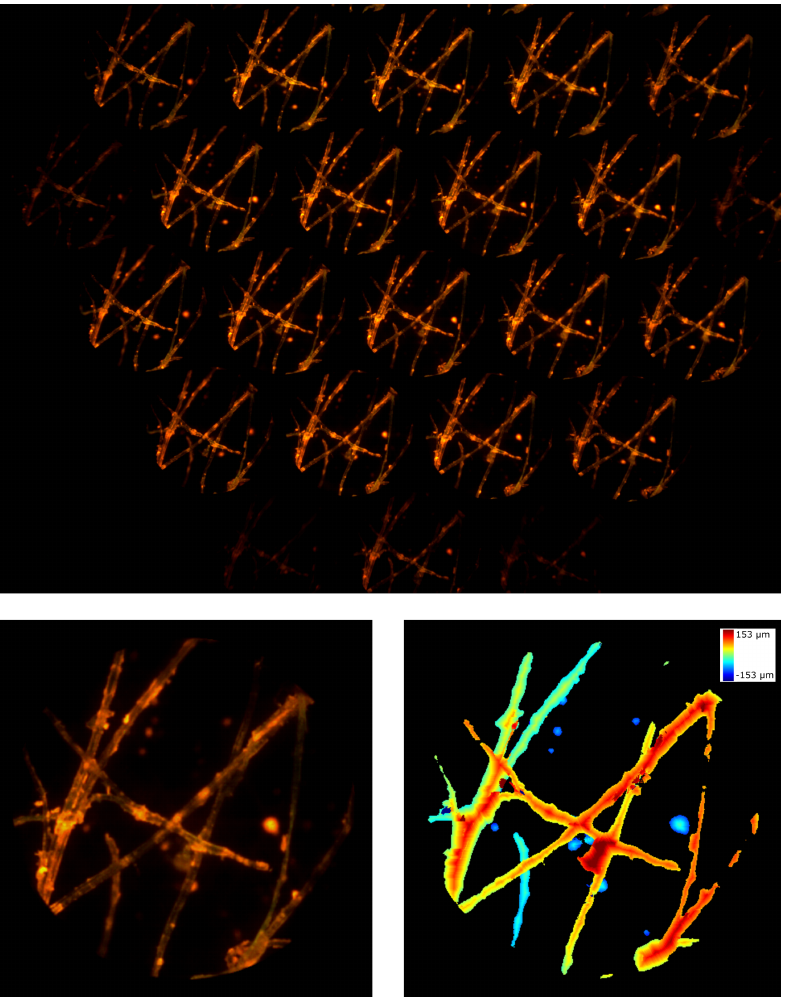
Figure 7. Cotton fibers. On the top, the entire frame registered by the device. On the bottom, the central perspective view and the depth map calculated from the lightfield